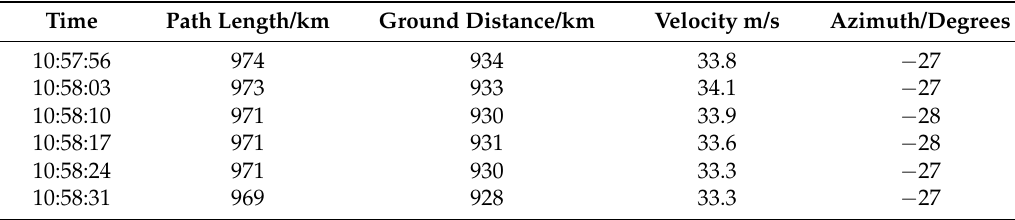
Figure 4. Actual data processing results (red dots represent the detection targets with positive speed (the target is approaching the radar), blue dots represent the detection targets with negative speed (the target is moving away from the radar), and the area between the red lines is the radar’s surveillance area). Table 1. Tracking parameters of Track A.